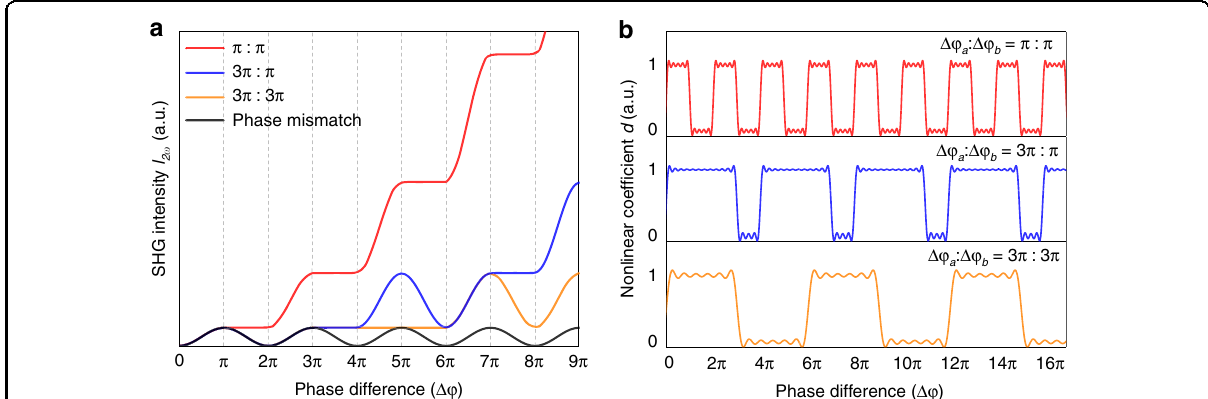
Fig. 2 APP phase matching with light phase manipulation for nonlinear frequency conversion. a SHG intensity ( I 2 ω ) under phase mismatch and different APP phase-matching conditions with phase difference Δ φ in a nonlinear crystal. The relative SHG intensities with light phase manipulation of Δ φ a : Δ φ b ¼ π : π ; 3 π : π and 3 π : 3 π correspond to the red, blue and orange lines, respectively. b Distribution of the second-order nonlinear coef fi cient d with the phase difference Δ φ